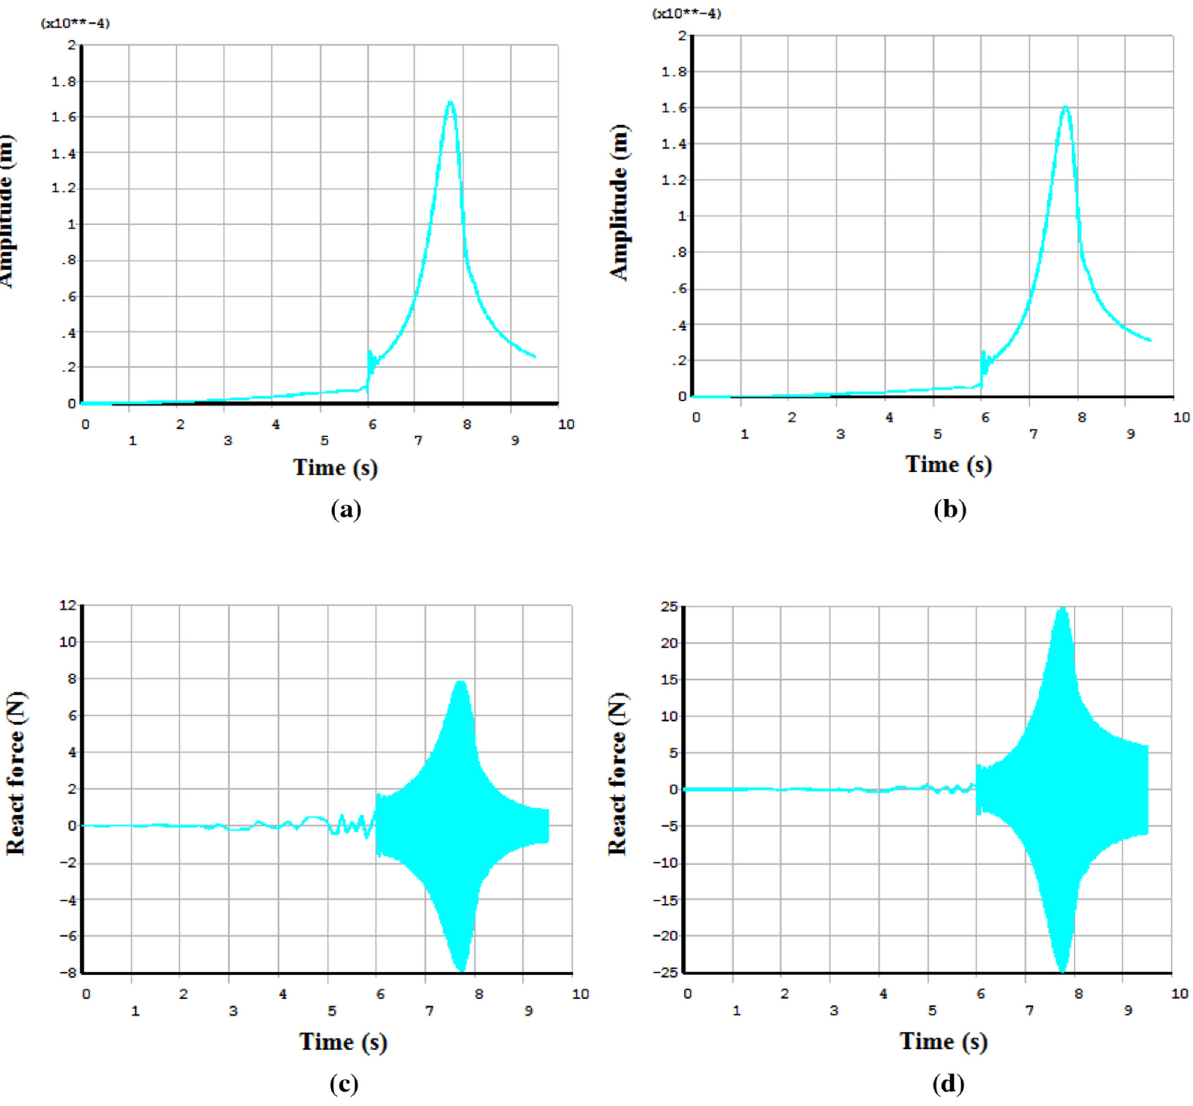
Fig. 3. Transient responses of the rotor. (a) Amplitude of disk1. (b) Amplitude of disk2. (c) React force on bearing1. (d) React force on